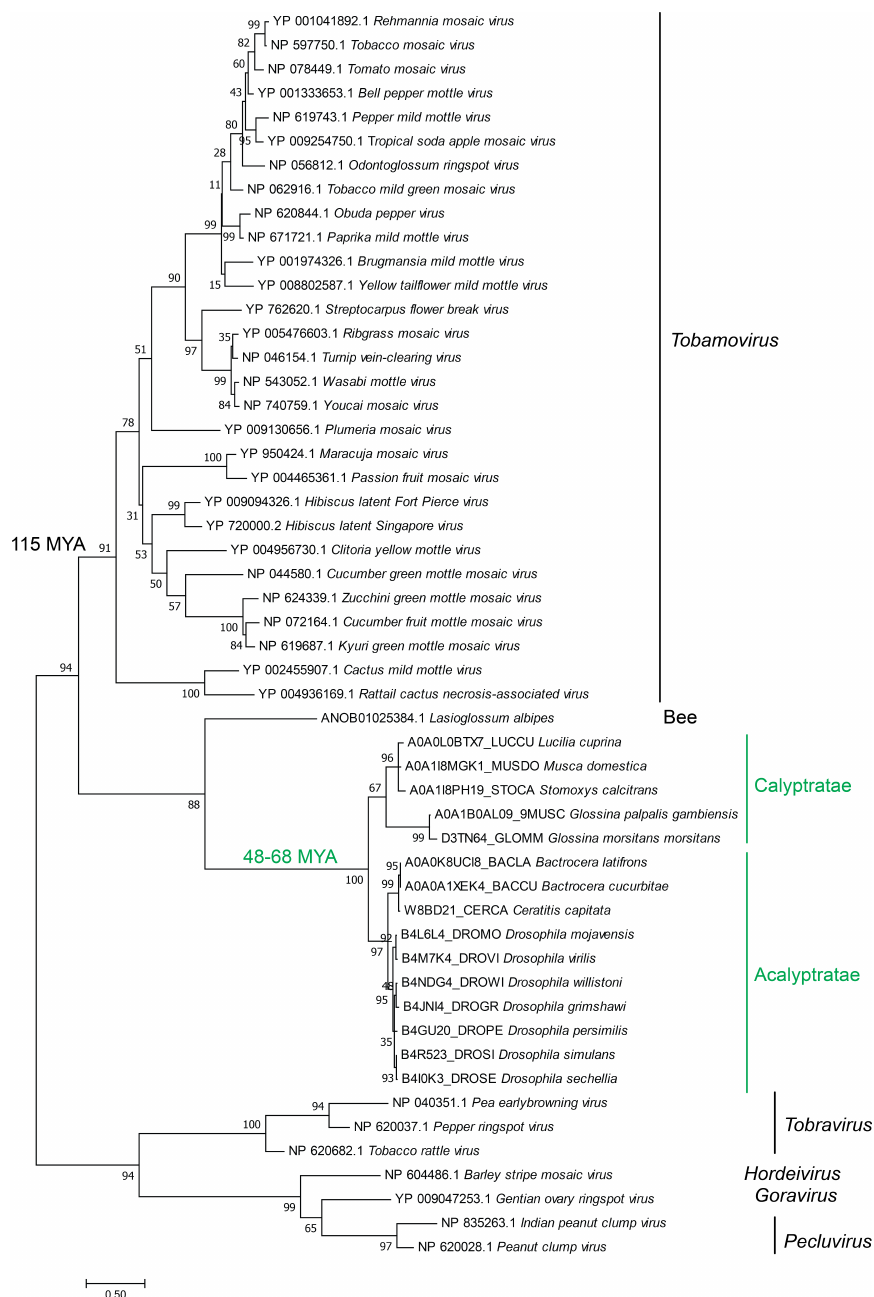
Figure 3. Phylogeny of eTCPLs and the corresponding viral sequences. The tree was constructed using the maximum likelihood method (LG + I + G + F model) using the MEGA program package [48]. All viral genera are monophyletically grouped according to their phylogeny. All the eukaryotic sequences are also grouped, and the pattern follows known fly phylogeny. The Acalyptratae-Calyptratae divergence from other flies [49–52] and Tobamovirus divergence from other Virgaviridae [53,54] have been noted. All flies are distributed to two main groups based on the two subsections of Schizophora flies: Acalyptratae and Calyptratae. All the eTCPLs from different flies cluster together with very high confidence and form a sister clade with extant viruses. The phylogenetic pattern inside the eTCPL clade is consistent with the divergence of flies in the Calyptratae and Acalyptratae subsections and resembles the phylogeny of the flies itself